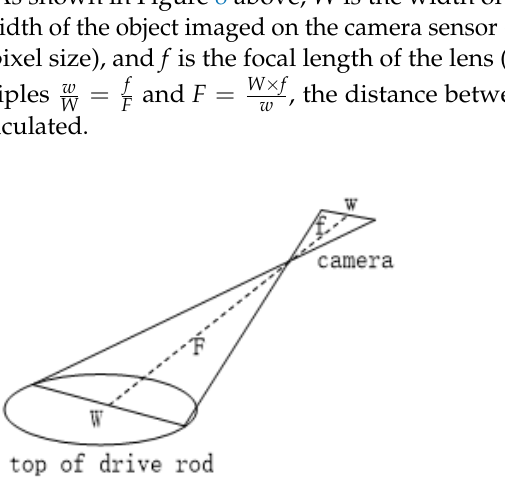
Figure 8. Driving-rod measurement